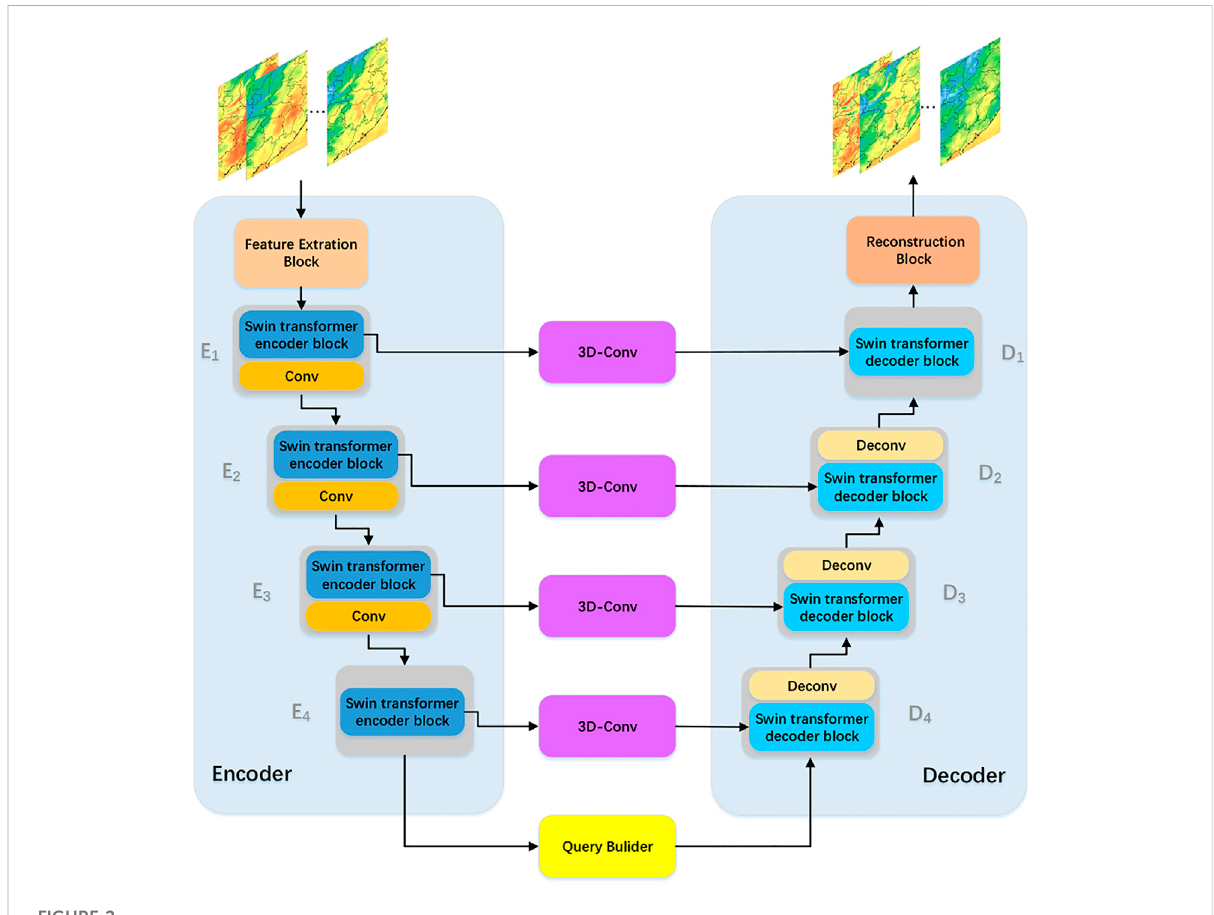
FIGURE 2 The overall structure of our proposes